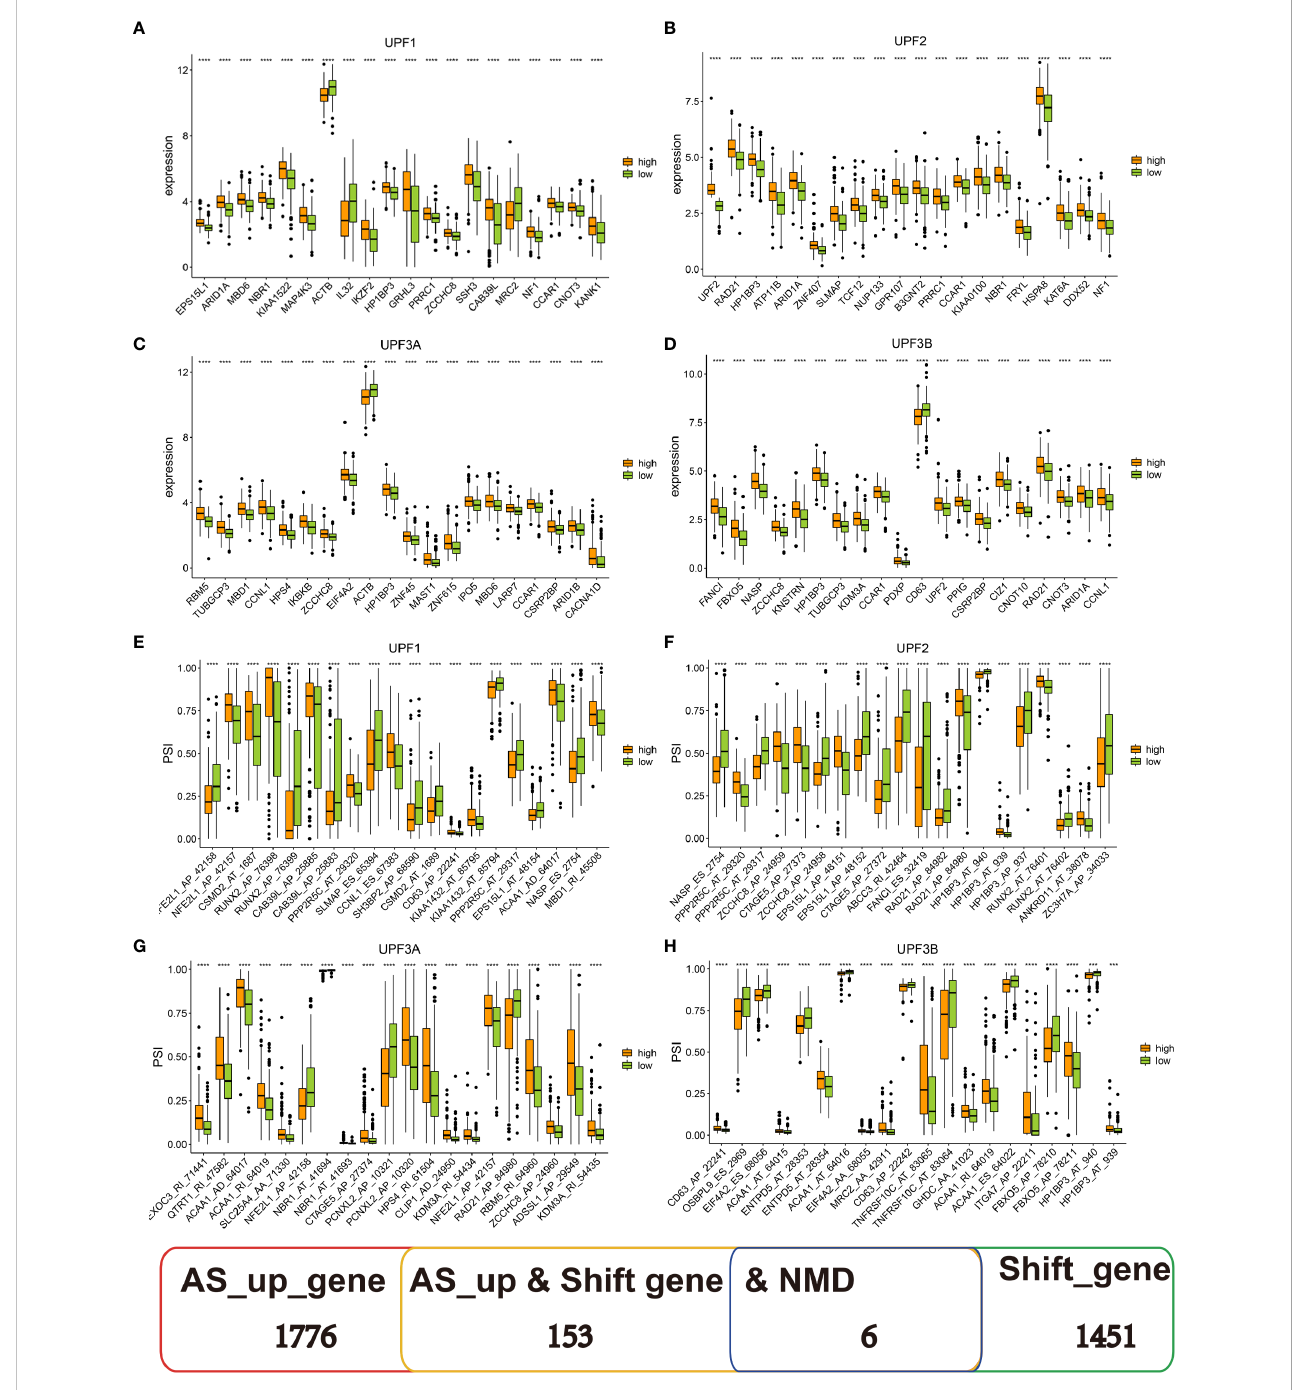
FIGURE 2 Identi fi cation of tumor antigens associated with nonsense-mediated mRNA decay factors. (A – D) The top 20 differentially expressed genes in four groups, including (A) UPF1, (B) UPF2, (C) UPF3A, and (D) UPF3B. (E – H) The top 20 CASEs in four groups, including (E) UPF1, (F) UPF2, (G) UPF3A and (H) UPF3B. *** P < 0.001, **** P <